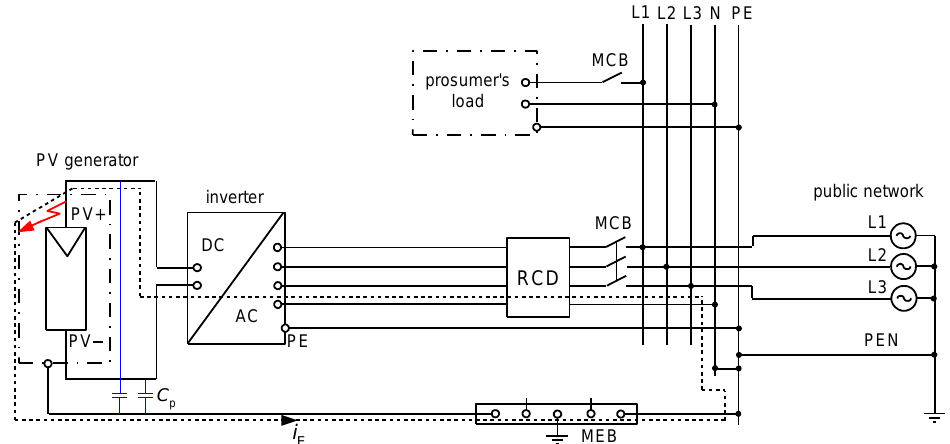
Figure 1. An example installation with photovoltaic (PV) sources of energy and earth fault current i E flow in the case of the earth fault at the DC side. RCD — residual current device, MCB — circuit-breaker, MEB — main equipotential bonding busbar, C p — capacitance-to-earth in a PV installation.